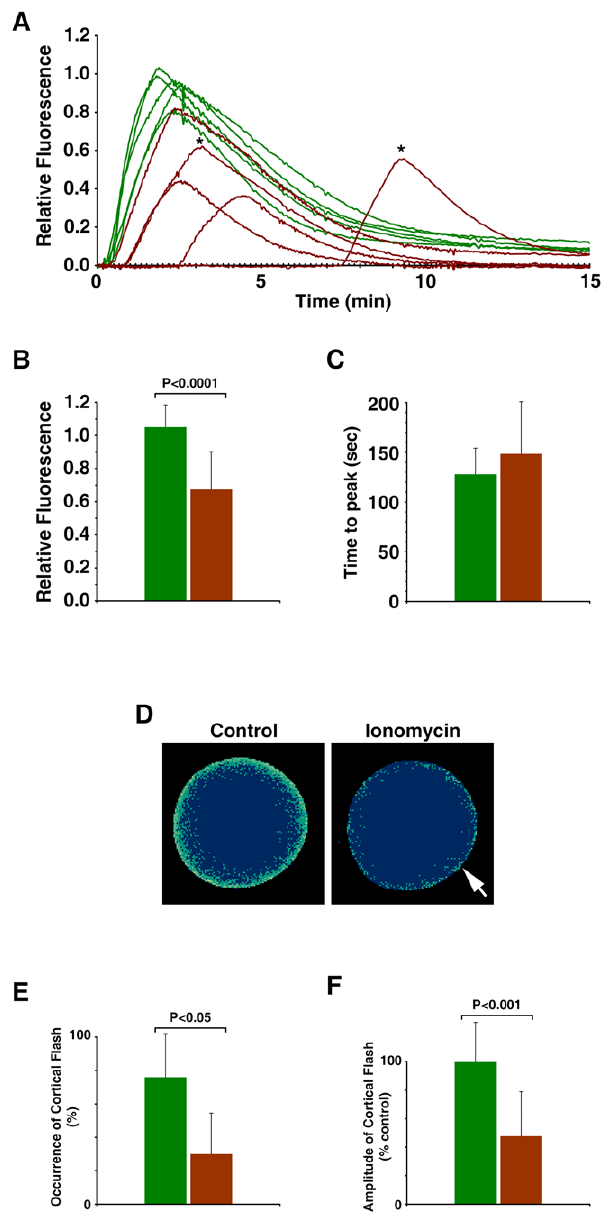
Figure 7. Fertilization of the ionomycin-pretreated eggs with altered cortical structure. A. aranciacus oocytes were briefly